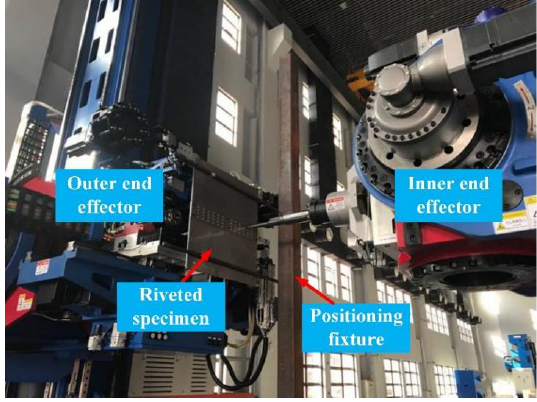
Figure 15. The riveted specimen production by automatic drilling and riveting system.